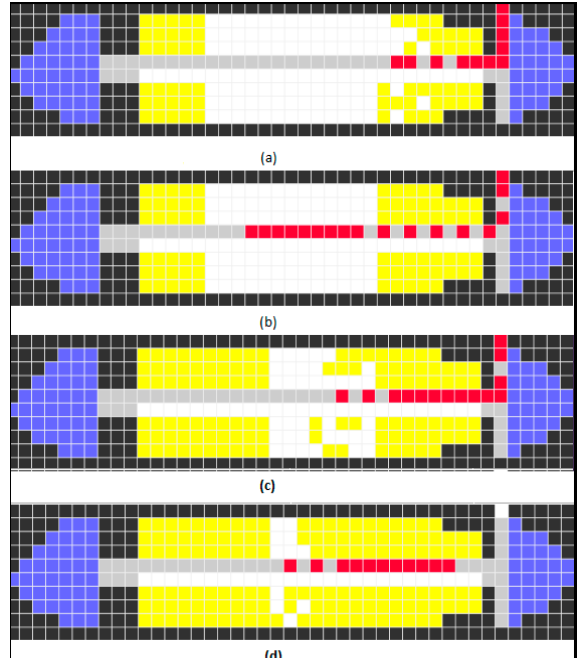
Figure 25. Zone rotate strategy.